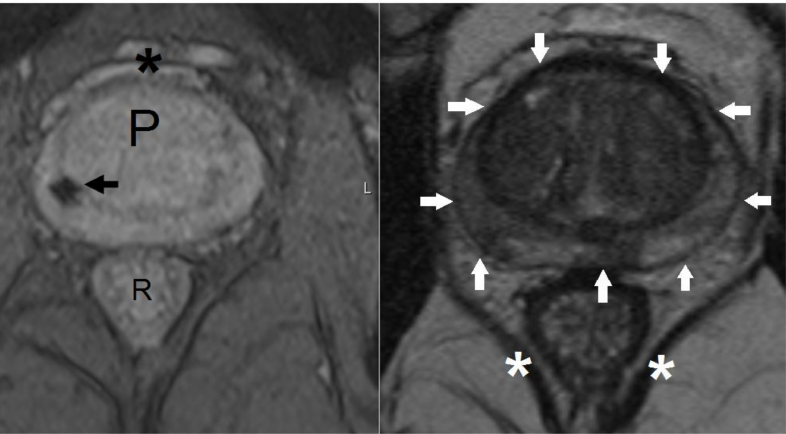
Figure 1. T2-weighted magnetic resonance (MR) sequences used for fusion with computerised tomography (CT) planning scan. Axial gradient echo (left pane) and T2 fast spin echo (right pane) MR images at the level of the prostate. Left pane: low signal void (black arrow) represents the site of a fiducial marker. P, prostate; R, rectum; *, venous plexus of Santorini. Right pane: white arrows show position of prostatic capsule. *, levator ani muscles.